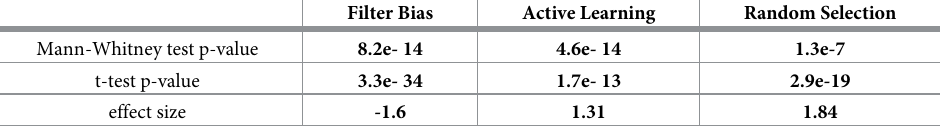
Table 12. Results of the Mann-Whitney U test and the t-test comparing the inequality of prediction for the three forms of iterated algorithmic bias with class-dependent human action probability ratio 10:1. The effect size is cal- culated as ( Gini | | )/ standard . dev . The negative effect size for filter bias shows that it increases the t = 0 − Gini t = 200 inequality. Both active learning and random selection decrease the inequality.